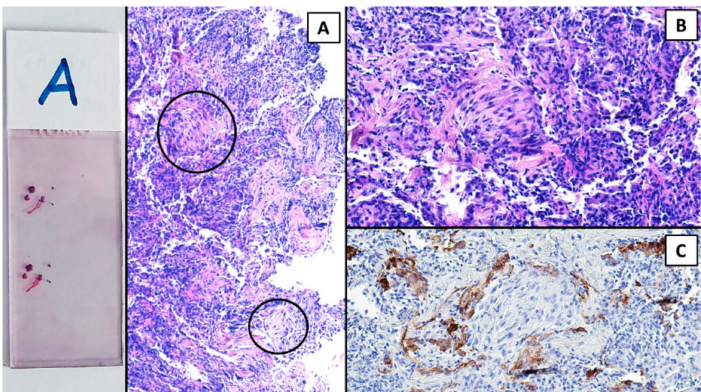
Figure 3. The pulmonary parenchyma in slide B was more preserved and expanded (( A ), H&E 10 × ); however, it showed only mild hyaline interstitial fibrosis and respiratory bronchiolitis. H&E 40 × . A collection of pigmented macrophages within the alveolar spaces at a higher power ( B ).